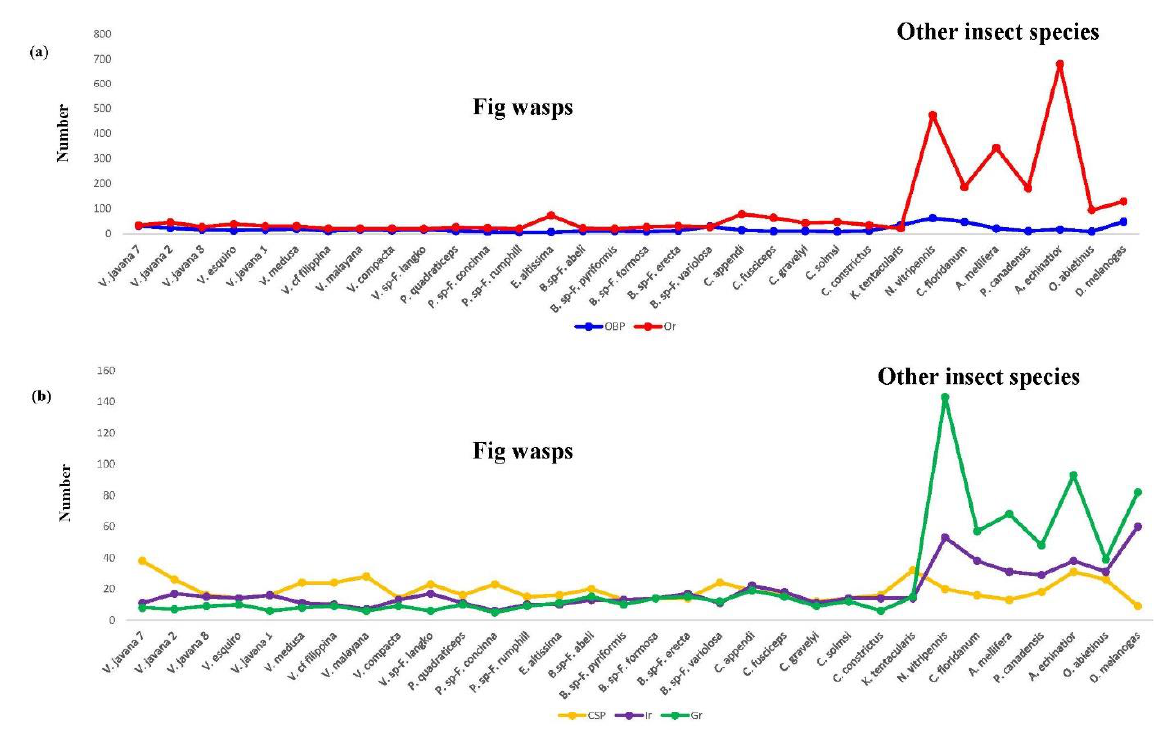
Figure 3. Comparisons of the numbers of genes identified as ( a ) odorant binding proteins (OBPs) and odorant receptors (Ors) and ( b ) as chemosensory proteins (CSPs), ionotropic receptors (Irs), and gustatory receptors (Grs). The numbers of genes in OBP and CSP families in fig wasps were similar to those in other insects, while the numbers of genes in Or, Ir, and Gr gene families were significantly lower in fig wasps.